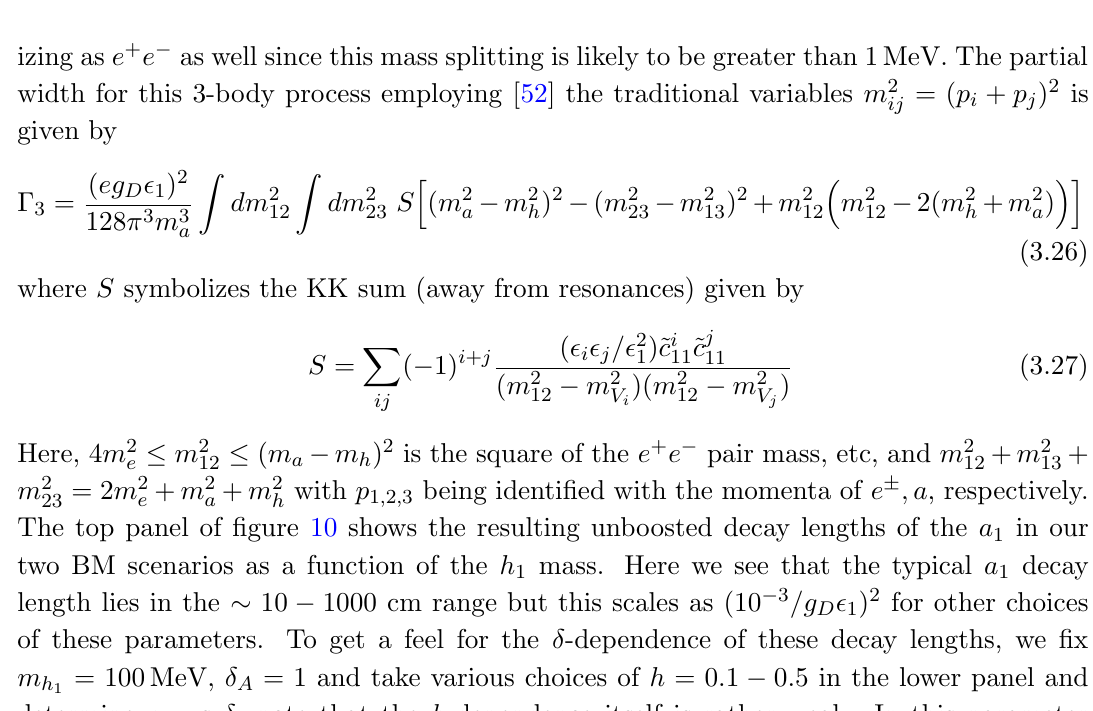
Table 4 . Masses of the lightest gauge and scalar KK states in units of m h considered in the